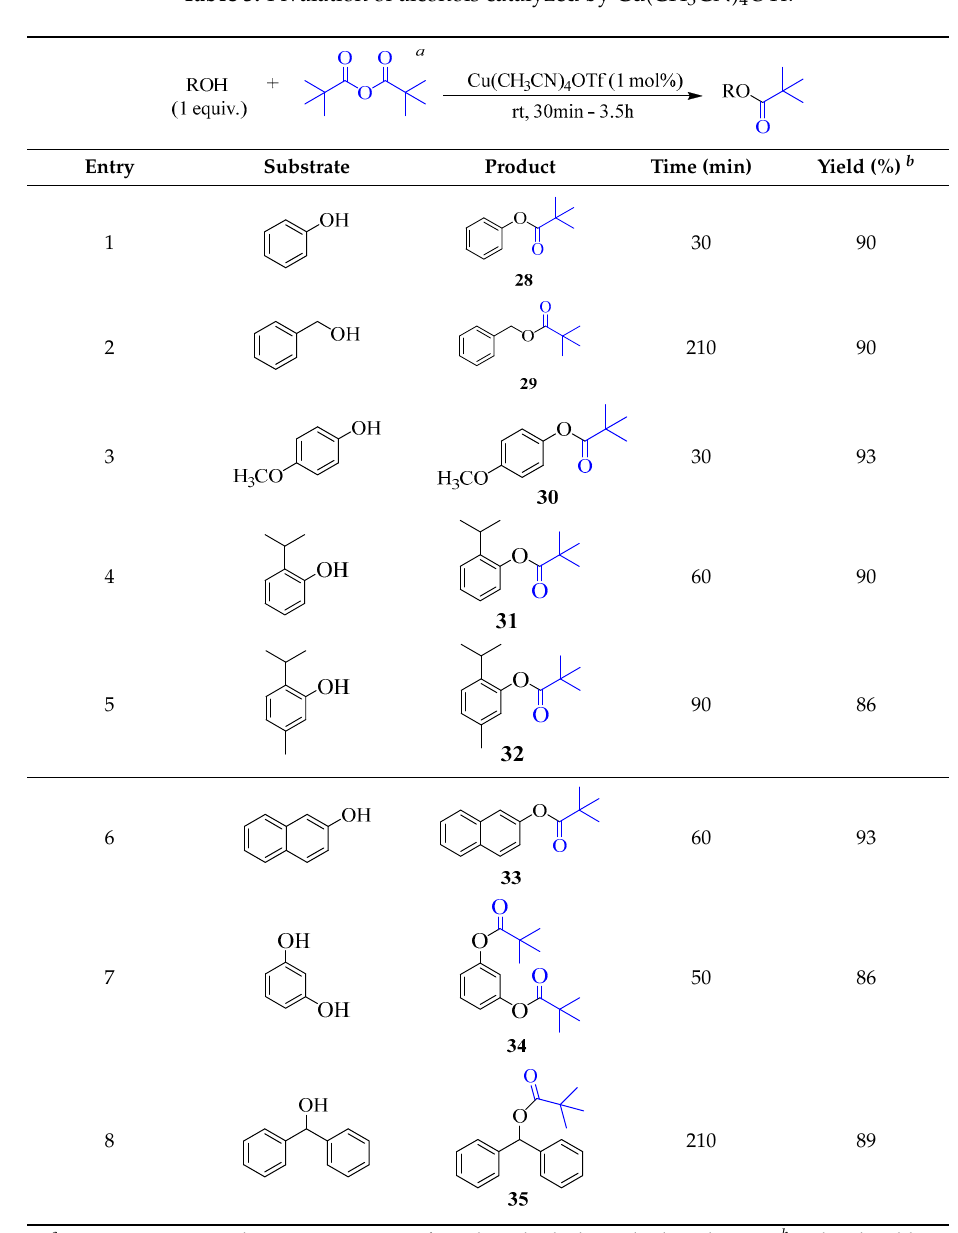
Table 3. Pivalation of alcohols catalyzed by Cu(CH 3 CN) 4 OTf.